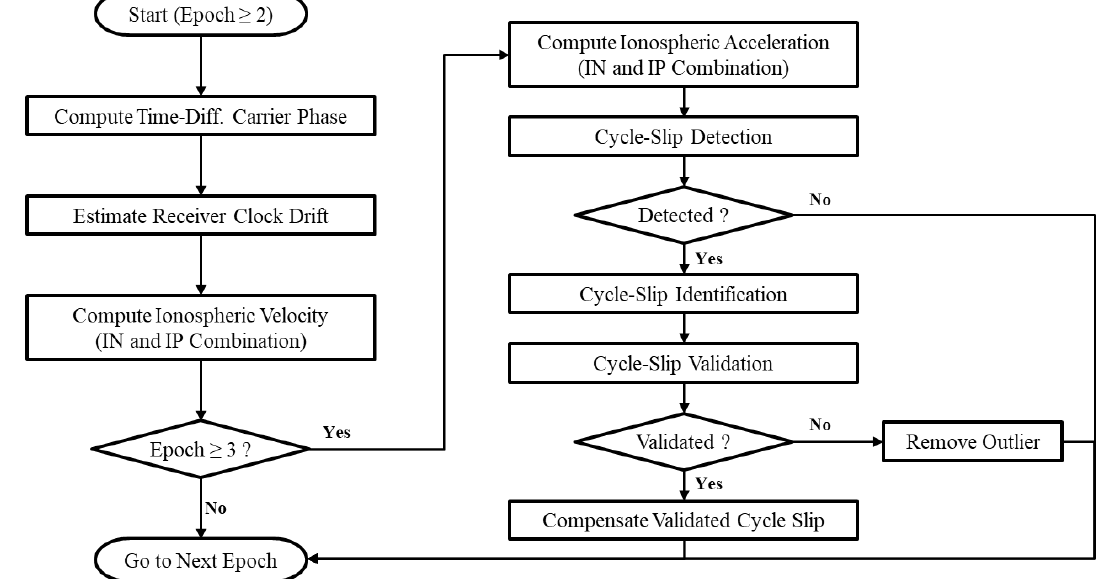
Figure 8. Block diagram of the overall cycle-slip detection and compensation algorithm.